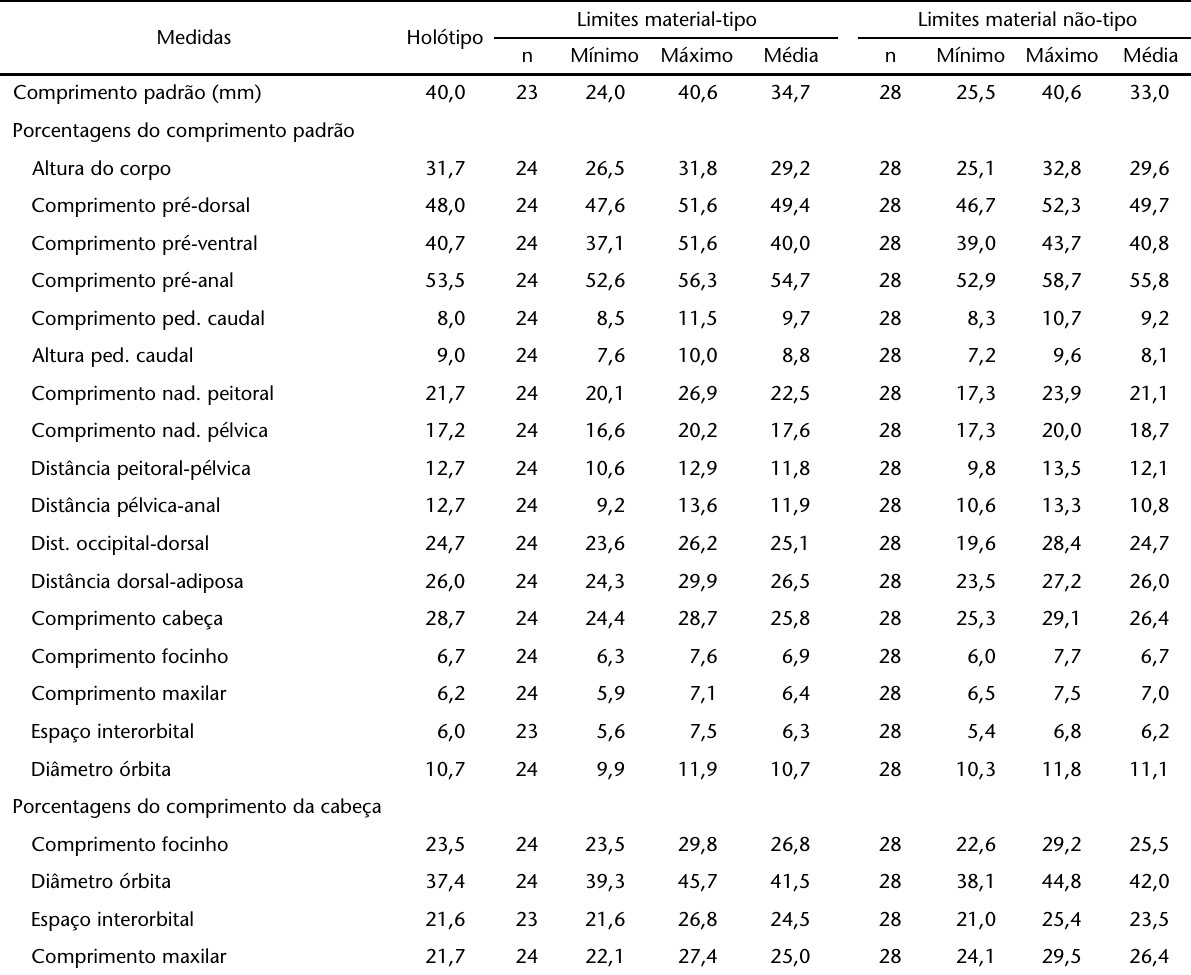
Tabela VI. Medidas de P. retropinnus sp. nov. , holótipo INPA 31367. (n) Número de exemplares, incluindo o